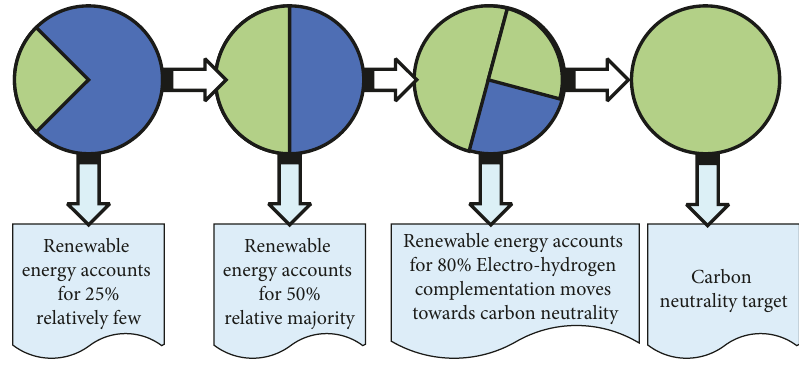
Figure 1: Three levels of evolution of the new power